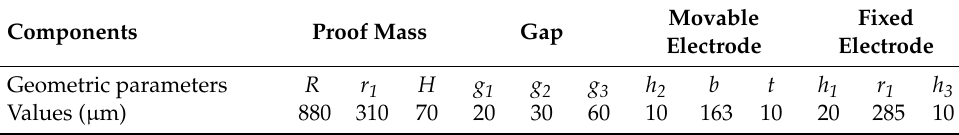
Table 2. The main geometric parameters of the designed inertial